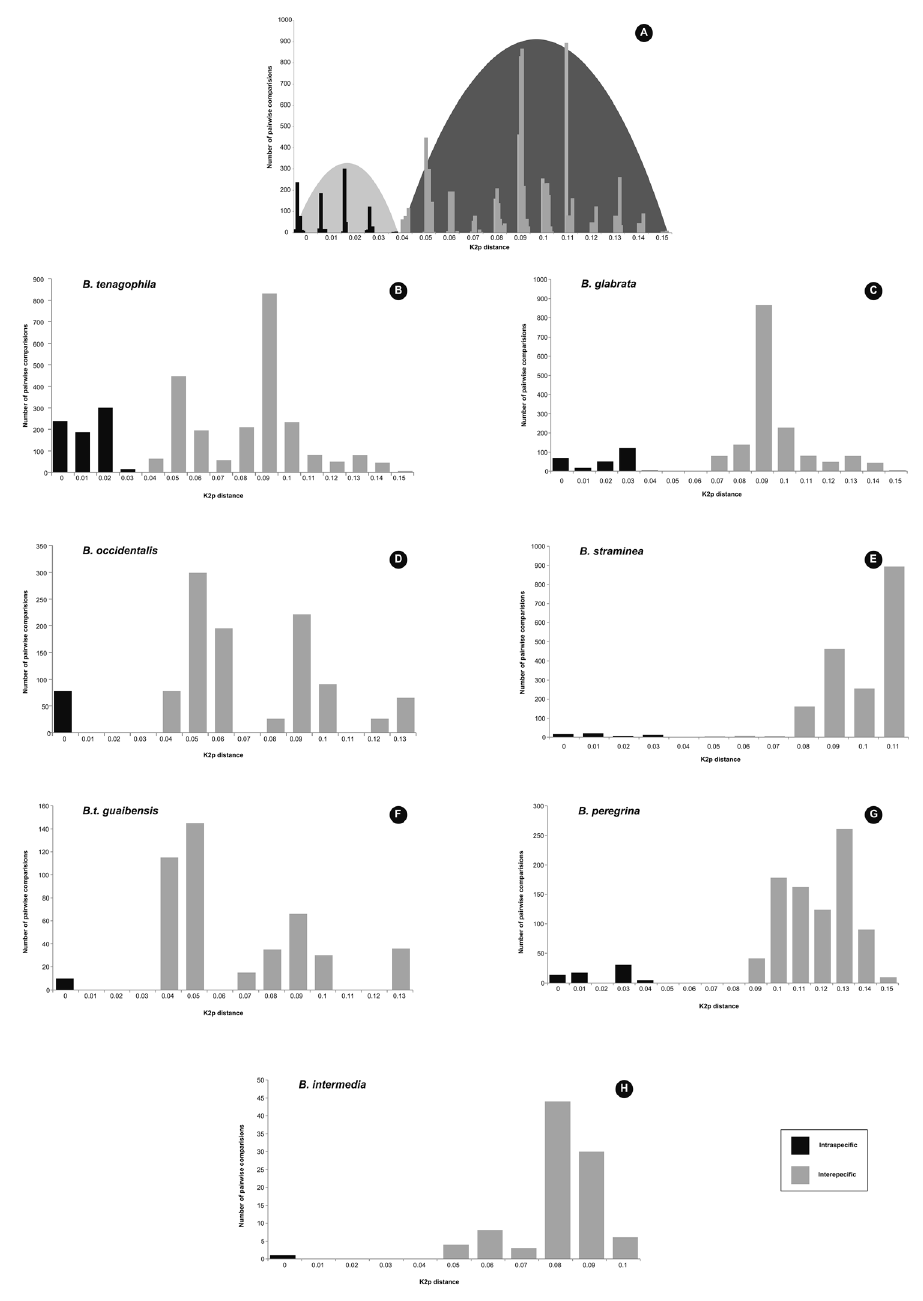
Figure 2. A histogram showing pairwise Kimura 2-parameter intraspecific and interspecific distances for 104 Biomphalaria cytochrome oxidase I sequences B–H pairwise distances between each species and the other taxa